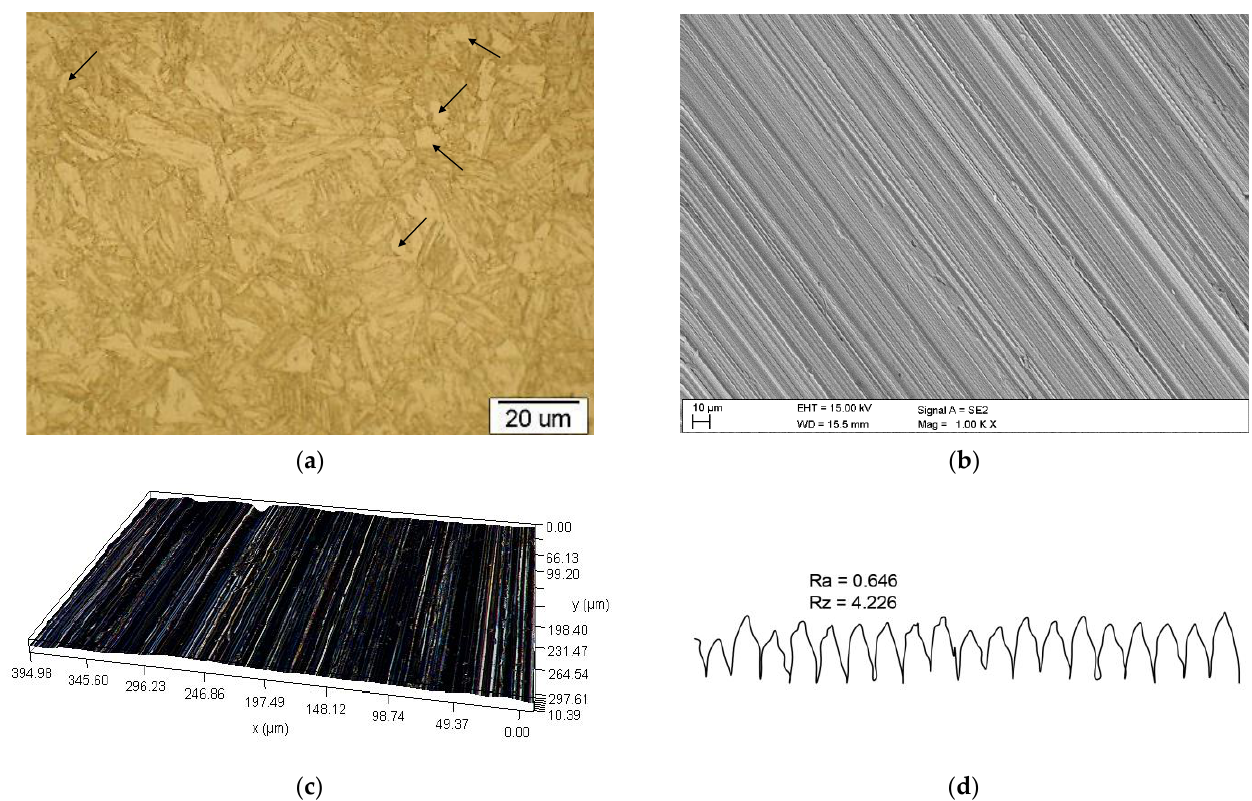
Figure 4. WRS_400_I steel, ( a ) Microstructure (OM), ( b ) surface view (SEM), ( c ) surface profile (DM), ( d ) roughness profile, areas of residual austenite are indicated by arrows.